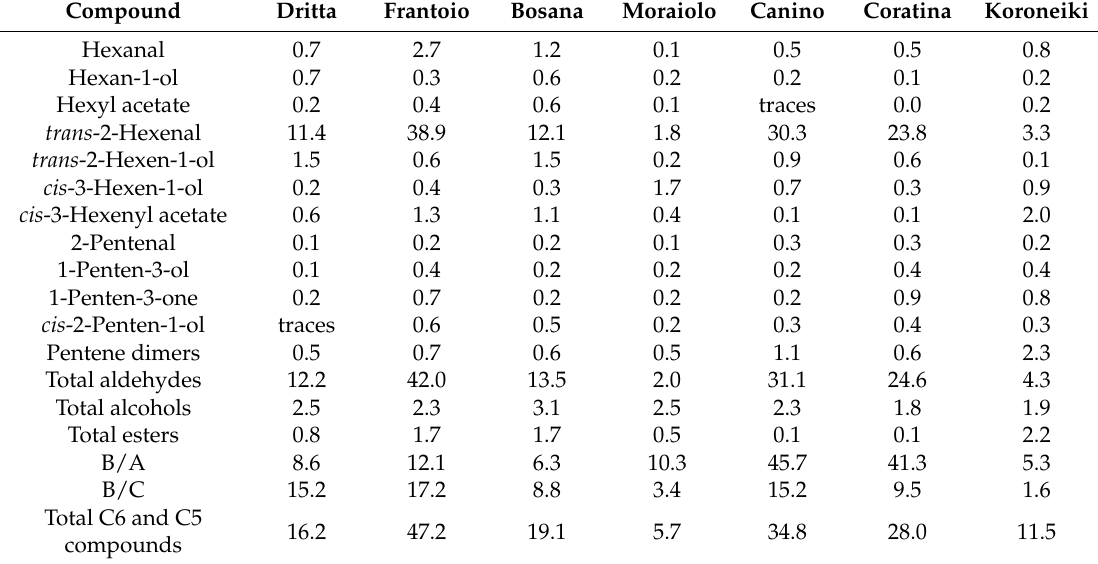
Table 2. Levels (mg/kg) of C6 and C5 volatile compounds in some extra virgin monovarietal olive oils. Results are expressed as mean of three samples of each monovarietal olive oil. A = all C6 compounds from LA; B = all C6 compounds from LnA; C = all C5 compounds. (Source: Authors; unpublished results). Compound Dritta Frantoio Bosana Moraiolo Canino Coratina